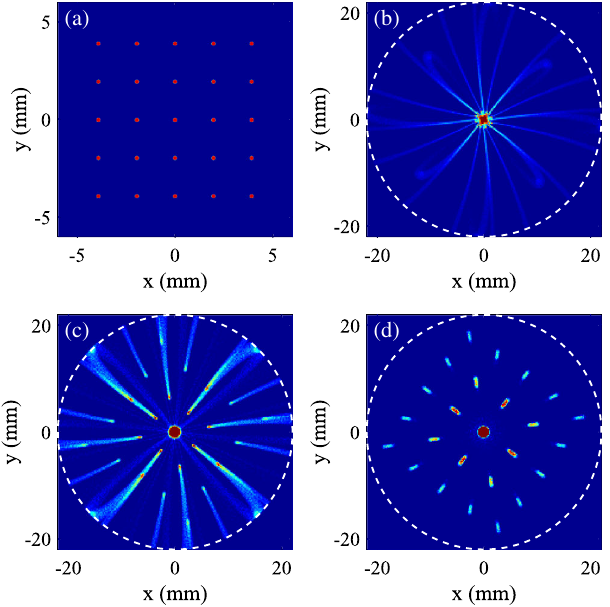
FIG. 11. ASTRA simulation results of the in situ field emission imaging system. (a) Field emitter distribution on the cathode, which consists of 25 ∅ 0 . 2 mm emitters separated by 1.77 mm. (b) Electron transverse distribution at the collimator position. (c) Electron transverse distribution on YAG 3 without applying the collimator. (d) Electron transverse distribution on YAG 3 with a ∅ 1 mm collimator. In (b) – (d), the white dashed circles represent the ∅ 44 mm YAG boundary.